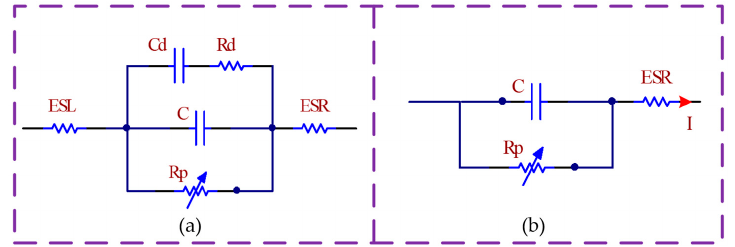
Figure 13. MLCC equivalent circuit model: ( a ) general equivalent circuit model of the MLCC; ( b ) simplified equivalent circuit model of the MLCC.